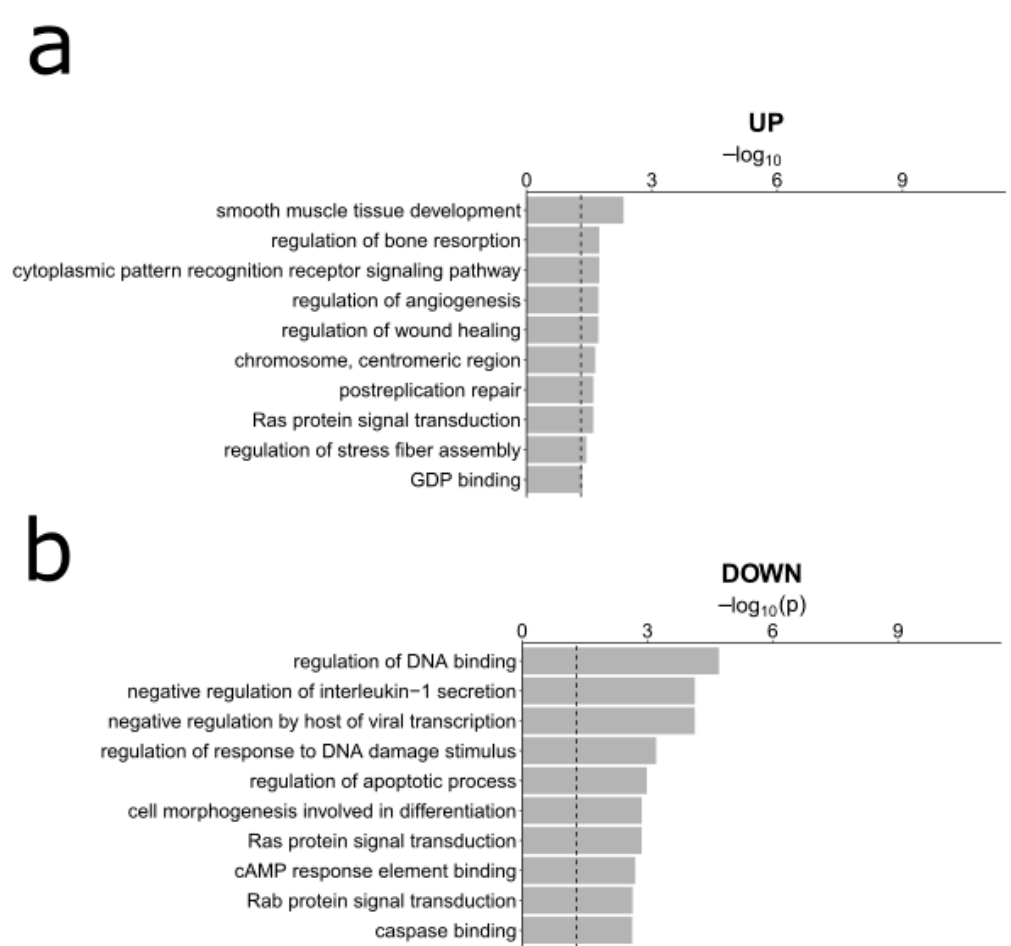
Figure A1. Gene Ontology (GO) analysis of the mRNAs associated with the di ff erentially expressed lncRNAs between pediatric B-ALL and healthy samples. The top 10 significantly enriched upregulated ( a ) and downregulated ( b ) GO terms are shown. Only non-redundant GO terms are included as described in Methods.